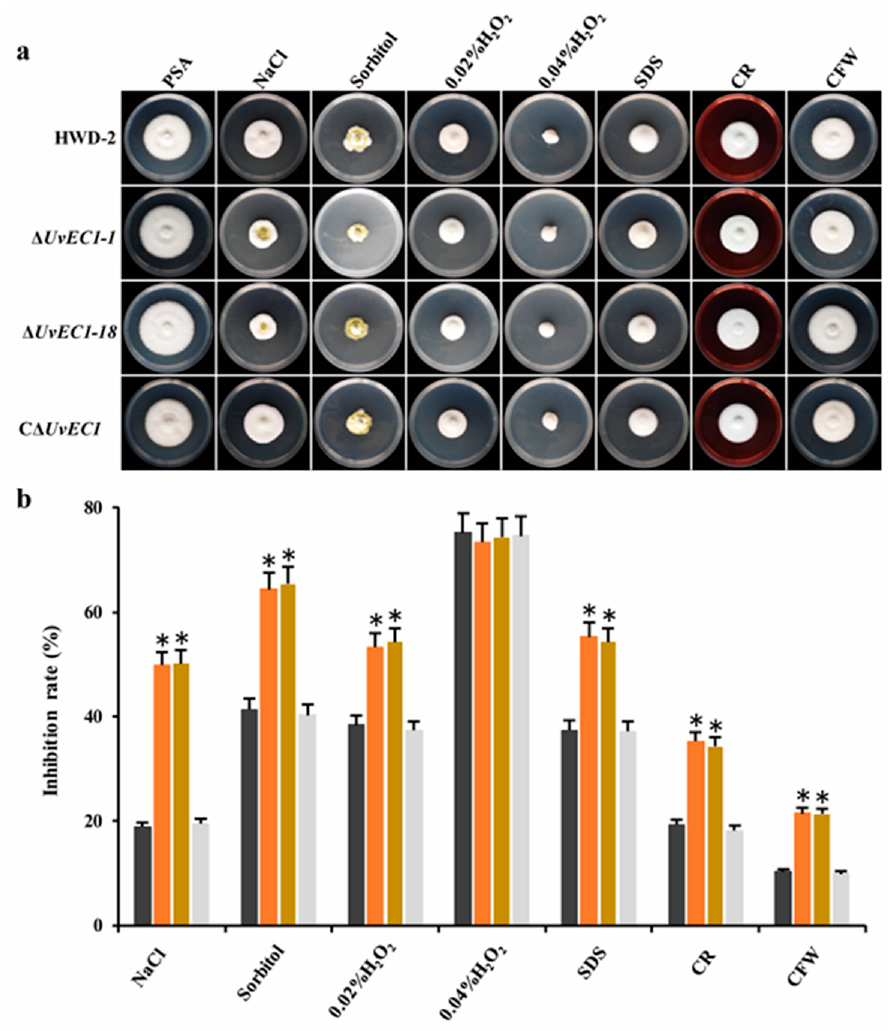
Figure 4. Sensitivity of ∆ UvEC1 mutants to various stresses. ( a ) Colony growth of HWD-2, UvEC1 mutants and the complementation strain on PSA medium containing various stress inducers after 14 days at 28 ◦ C in the dark. ( b ) Rates of growth inhibition of colonies by the stress inducers shown in a. Asterisks represent significant differences relative to HWD-2, as determined by LSD at p = 0.05. 2.5. Deletion of UvEC1 Affects the Pathogenicity of U. virens To investigate the roles of UvEC1 in the virulence of U. virens , we assessed the pathogenicity of all strains by inoculation on susceptible rice (cultivar ‘Wanxian98’) pani- cles at the early booting stage. At 21 days post inoculation (dpi), we observed the typical symptoms consisting of yellow smut balls on rice spikelets infected with HWD-2, ∆ UvEC1 mutants and complementation strain (Figure 5a). However, their number per panicle was much lower in plants infected with the ∆ UvEC1 mutants than in plants infected with either the WT or complementation strains (Figure 5b). Thus, deletion of UvEC1 reduces the virulence of U. virens